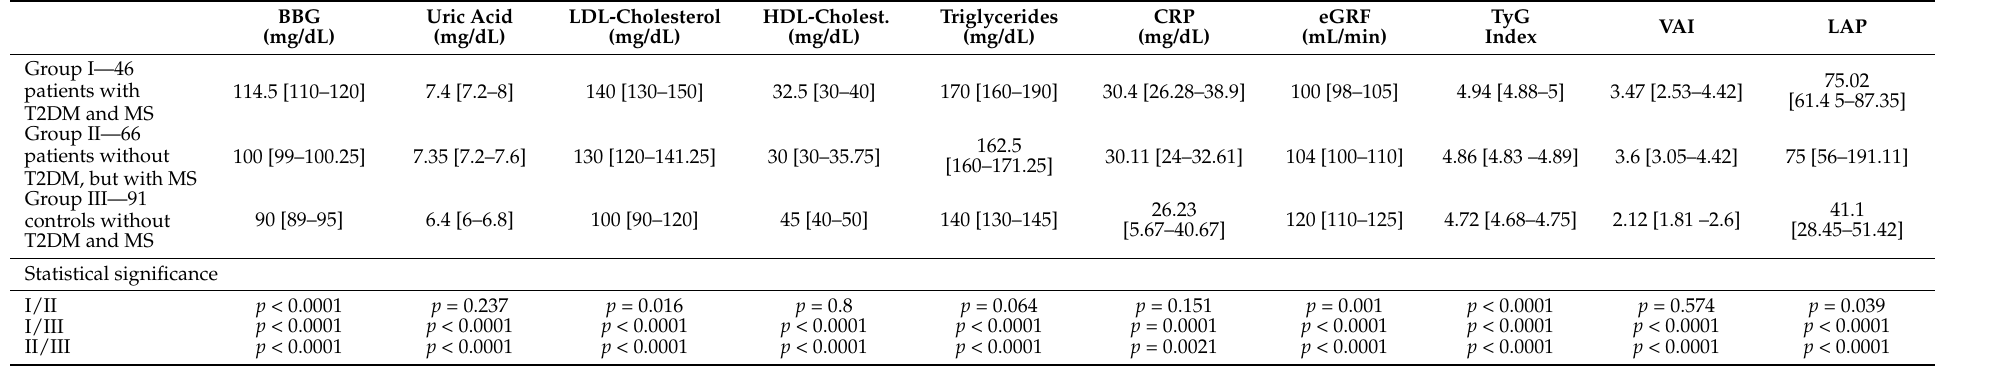
Table 2. Patient laboratory characteristics.